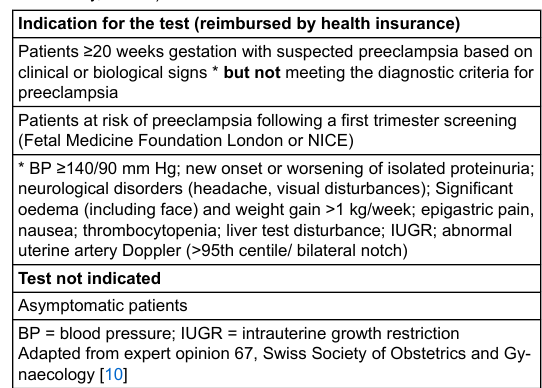
Table 2: Indications for the use of the sFlt1/PlGF ratio (Elecsys im- munoassay,